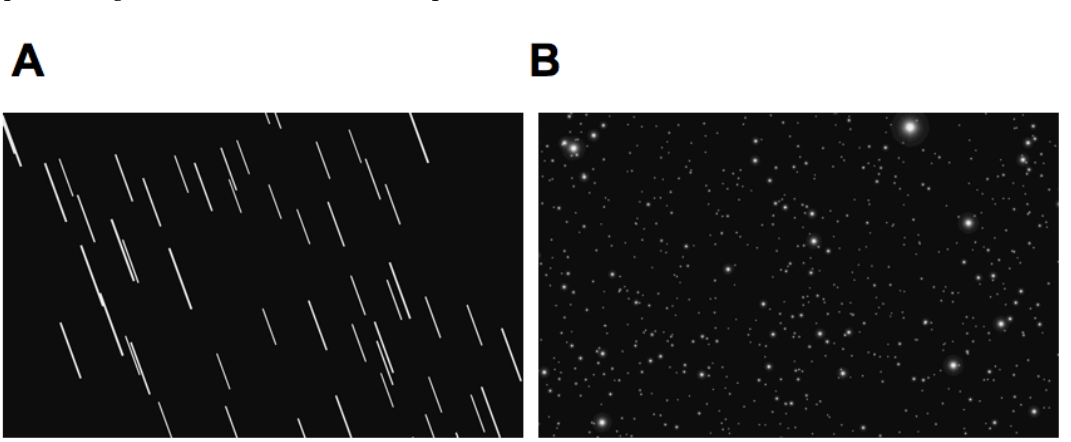
Figure 5. The mean ( A ) Point of subjective verticality ( PSV) and ( B ) Just noticeable difference (JND) averaged across observers as a function of head tilt and stimulus type (±1 standard error of the mean (SEM)). A lower JND represents greater certainty or precision in judging the stimulus tilt.